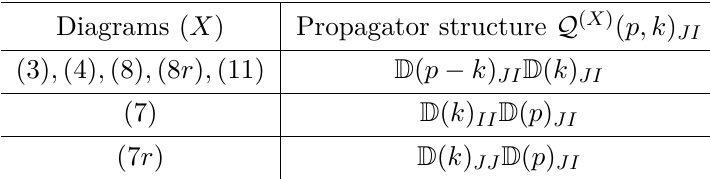
Table 5. Summary of propagator structures of diagrams with 2 propagators contributing to (cid:2) (cid:3) da g ++ E ji,JI